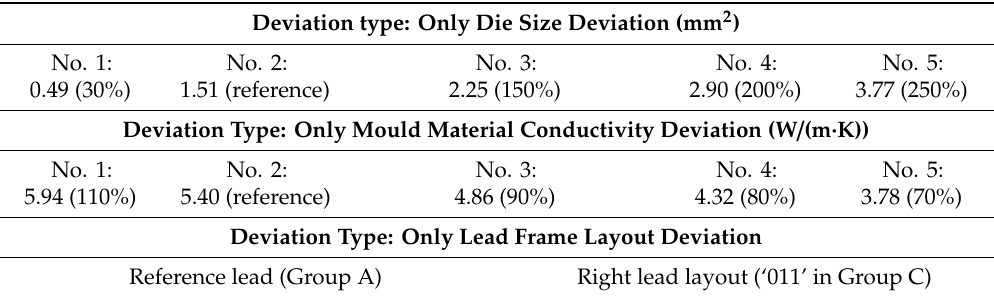
Table 2. Model attribute